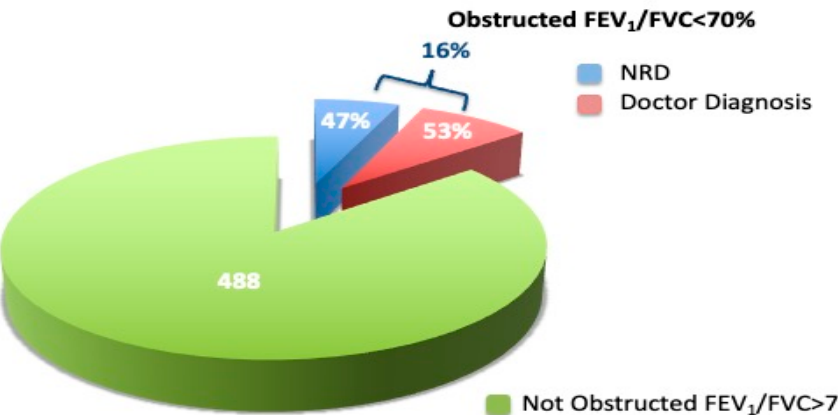
Figure 2. Prevalence of the studied variables for median age (65 years).